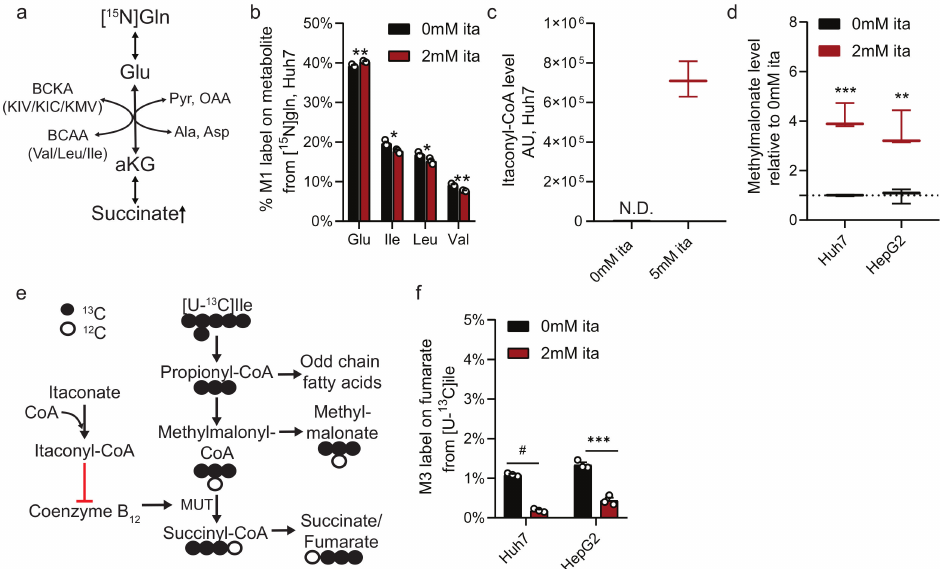
Figure 4. Itaconate influences methylmalonyl-coenzyme A (CoA) mutase (MUT) dependent BCAA metabolism. ( a ) Schematic depicting nitrogen exchange from [ α - 15 N]glutamate on branched-chain amino acids (BCAA) and branched-chain keto acids (BCKA). ( b ) Labeling on amino acids from [ α - 15 N]glutamine in Huh7 cells cultured for 48 h in the presence of 2 mM itaconate. ( c ) Itaconyl-CoA levels depicted as ion counts (m/z = 880.1379) in Huh7 cells. N.D. not detectable. ( d ) Methylmalonate levels in Huh7 or HepG2 cells exposed to 2 mM itaconate for 48 h compared to 0 mM itaconate (dotted line). ( e ) Schematic depicting methylmalonyl-CoA mutase (MUT) dependent BCAA catabolism. Open circles depict 12 C, closed circles 13 C carbons from [U- 13 C 6 ]isoleucine tracer. ( f ) M3 label on fumarate from [U- 13 C 6 ]isoleucine in Huh7 and HepG2 cells exposed to 2 mM itaconate for 48 h. Data are depicted as box and whiskers ( c , d ) or mean ± s.e.m. ( b , f ) obtained from 3 cellular replicates. Students t -test with no adjustment for multiple comparisons and * p < 0.05, ** p < 0.01, *** p < 0.001, # p <